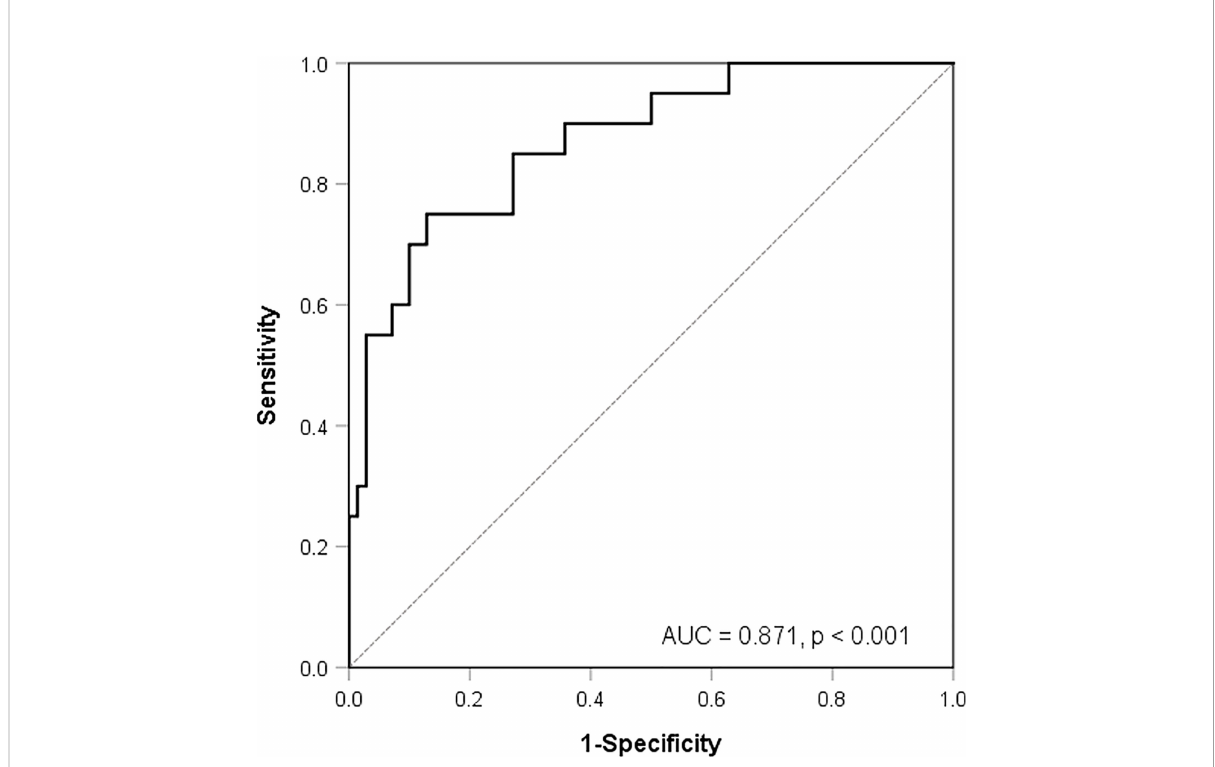
FIGURE 2 Receiver-operating characteristic curve analysis for the prediction of MYCN ampli fi cation according to a model composed of two texture